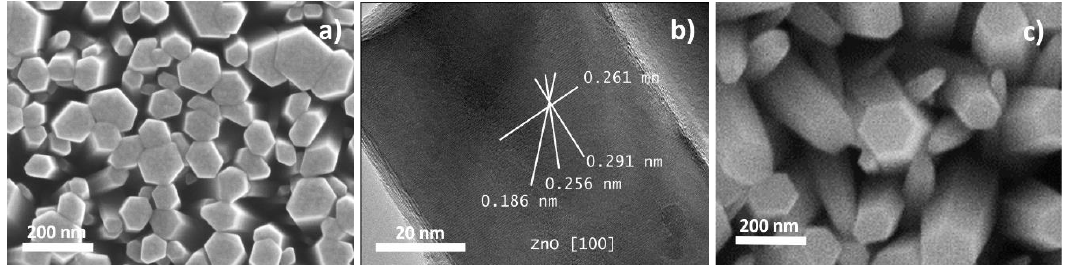
Figure 3. SEM ( a ) and TEM ( b ) images of the ZnO NRs grown on the silicon substrate and ( c ) SEM image of the ZnO NRs prepared on the sensing platform.